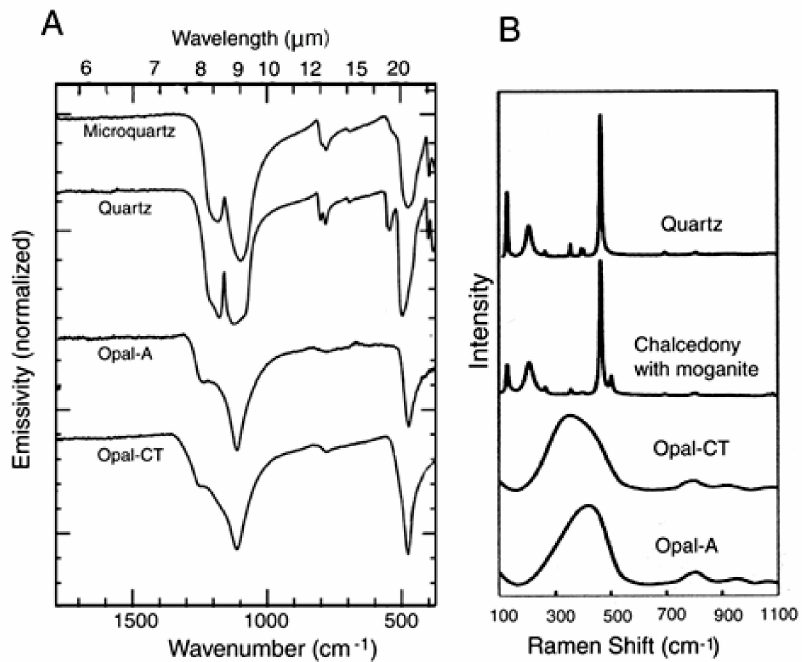
Figure 20. Examples of FTIR and Raman spectra for silica polymorphs. ( A ) FTIR spectra of silica minerals [83]. ( B ) Raman map of silica phases in silicified wood from the Morrison Formation, Escalante State Park, Utah, USA